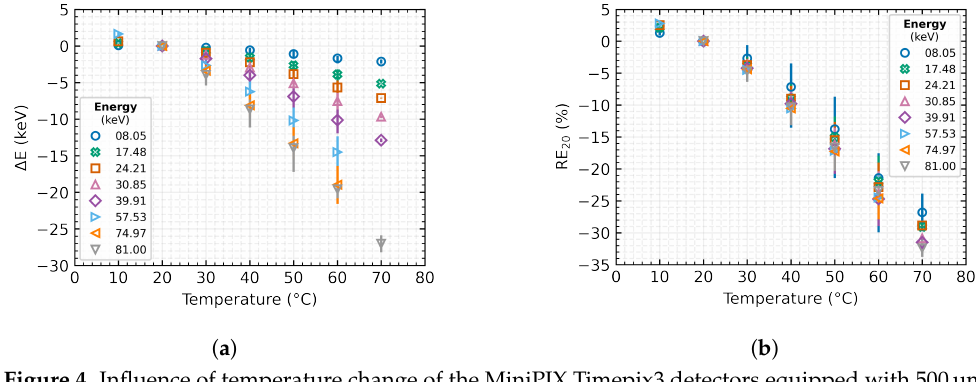
Figure 4. Influence of temperature change of the MiniPIX Timepix3 detectors equipped with 500µm Si sensor on the obtained energetic spectrum measured by Time-over-Threshold in data-driven mode. The plotted data represent the mean values over the tested detectors, and the error bars indicate their minimum and maximum value: ( a ) Absolute measurement accuracy; ( b ) Relative error of